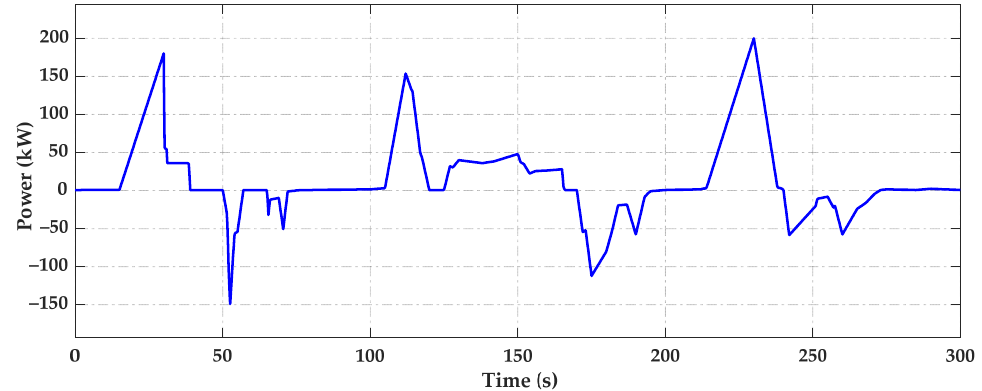
( b ) Figure 4. The average-value DC/DC converter model. ( a ) Boost mode; ( b ) Buck mode. Where D is the duty cycle (%), L is the inductance (H), ϕ is the positive gain, L C and